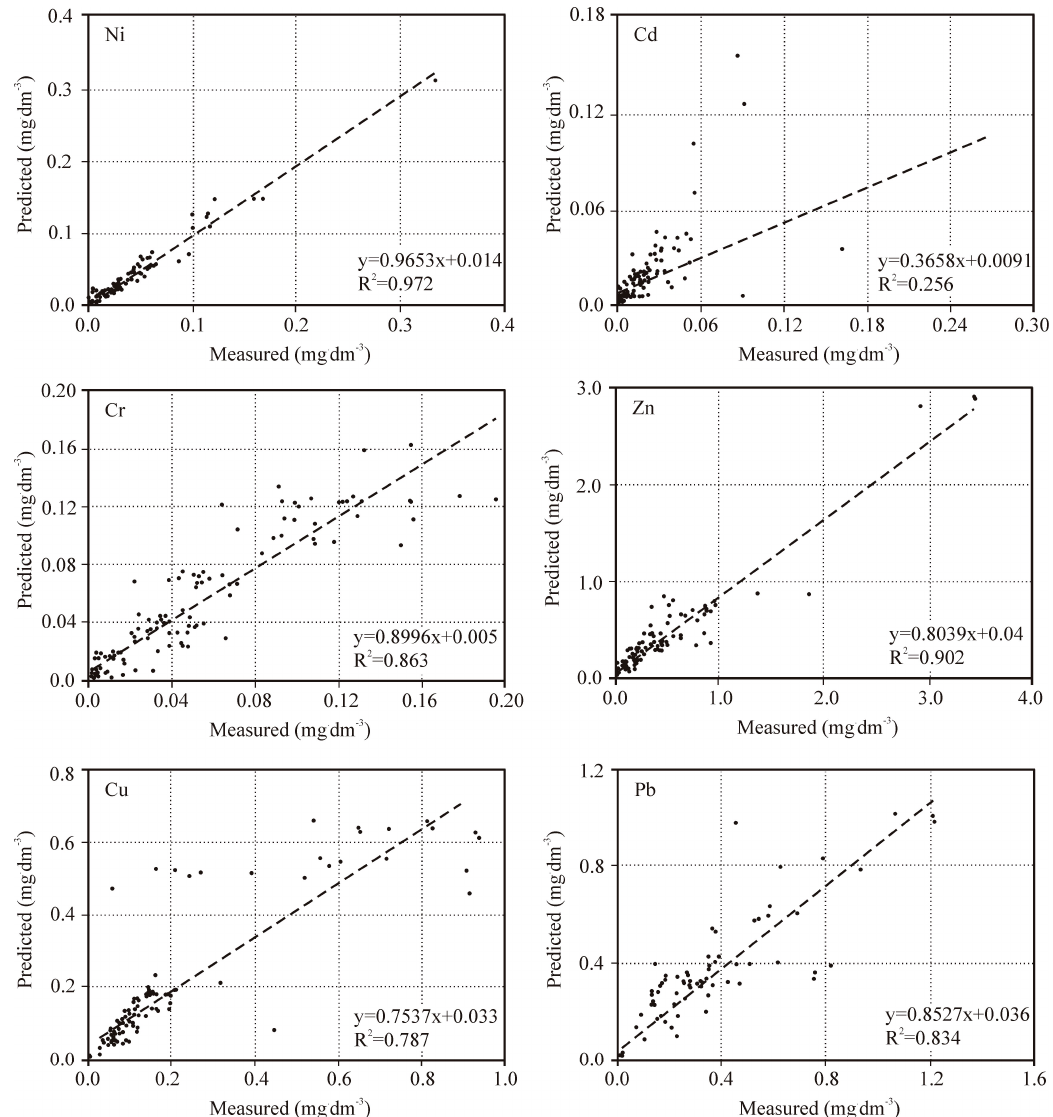
Figure 5. Predicted versus observed HM concentrations in stormwater (validation step).